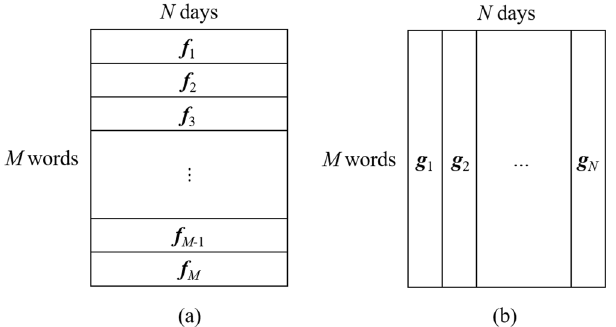
Figure 9. We observe the frequencies of M words for N days. ( a ) The frequencies of the i th word for N days are denoted by